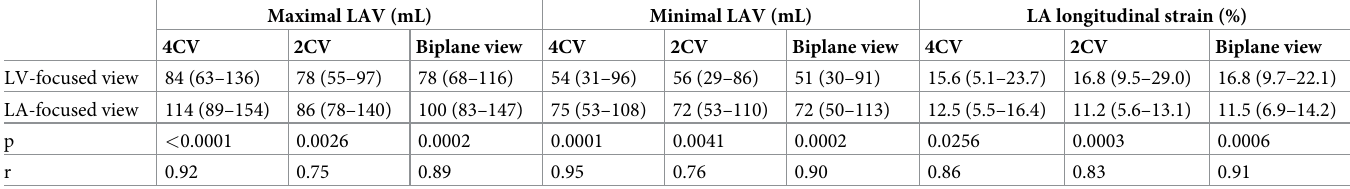
Table 7. Comparison of left atrial volumes and strain between LV-focused view and LA-focused view in 15 CMR cases.